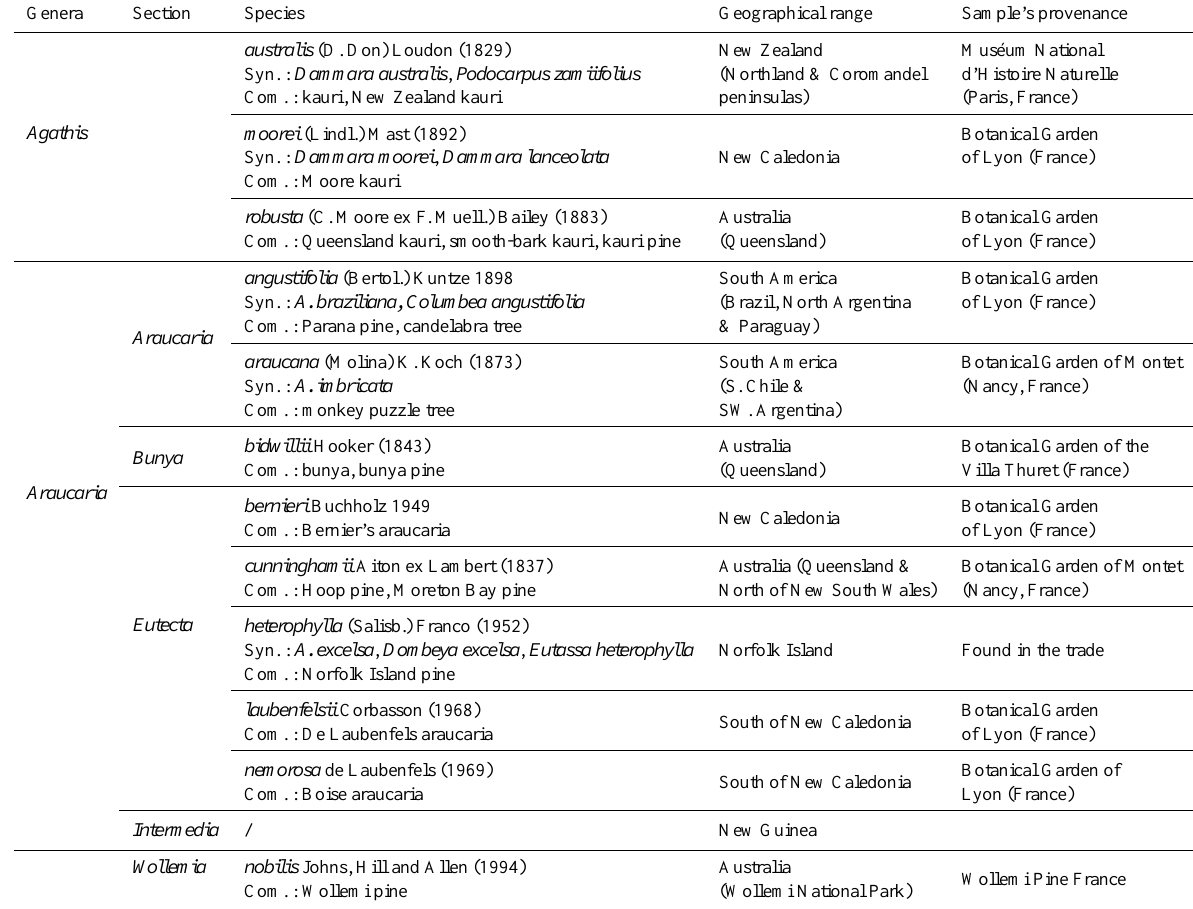
Table 1. Phylogentic relationships, geographical range and provenance of Araucariaceae species selected for this study.